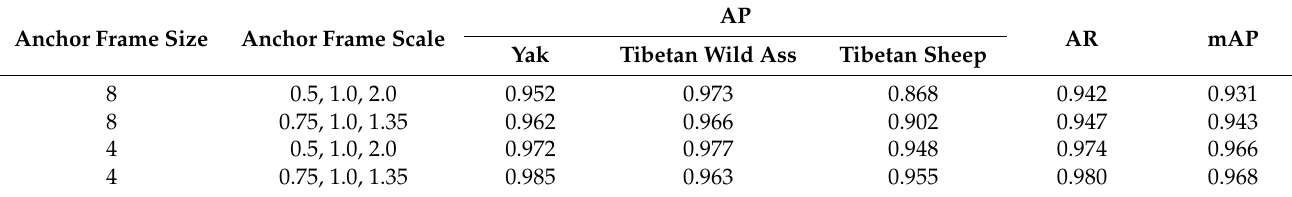
Figure 13. Modified anchor frame size experimental PR curves: ( a ) the PR curve of the experiment with anchor frame foundation size of 8, and proportions of 0.5, 1, and 2; ( b ) the PR curve of the experiment with anchor frame foundation size of 8, and proportions of 0.75, 1, and 1.35; ( c ) the PR curve of the experiment with anchor frame foundation size of 4, and proportions of 0.5, 1, and 2; ( d ) the PR curve of the experiment with anchor frame foundation size of 4, and proportions of 0.75, 1, and 1.35. Table 2. Test results before and after modifying the size and proportions of the anchor frame when IoU was